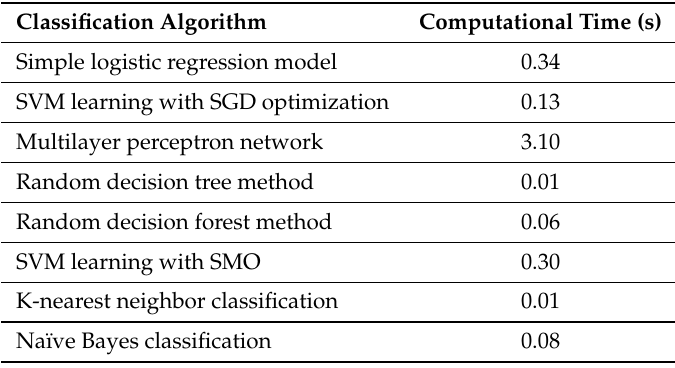
Table 1. Computational times for the classification